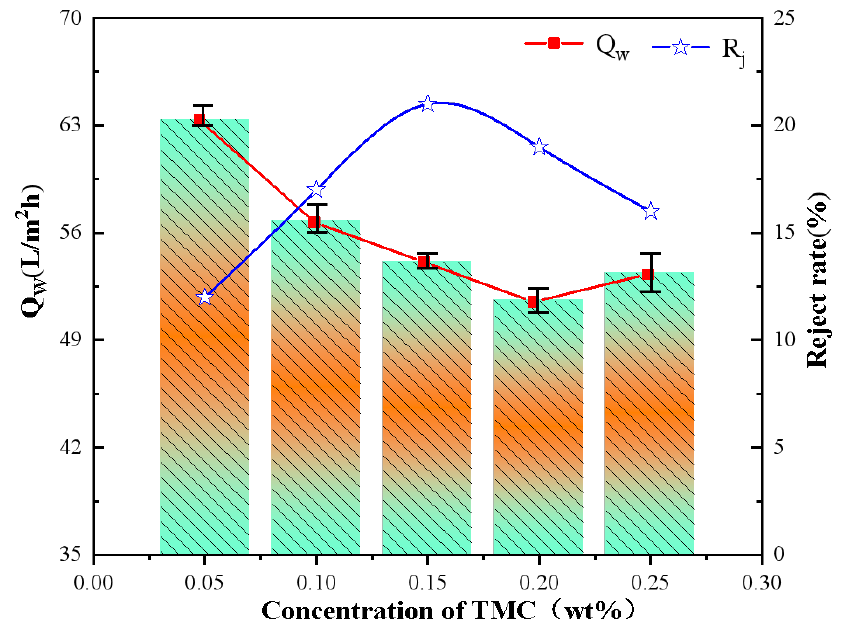
Figure 4. Influence of TMC concentration on the water flux ( Q w ) and salt filtration performance (R j ) of NFMs.